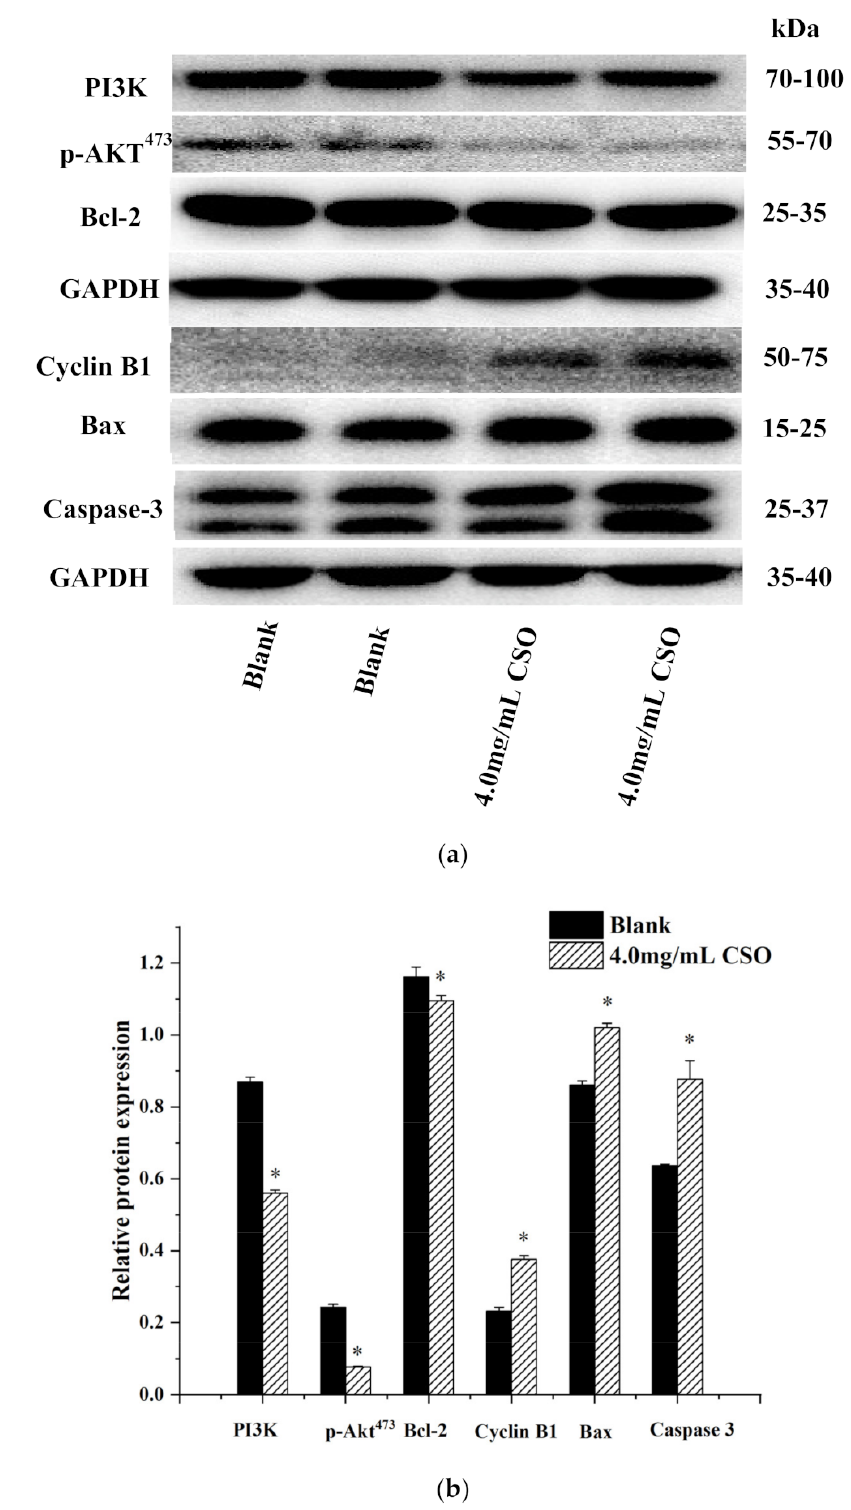
Figure 7. ( a ) Protein bands of PI3K, p-AKT 473 , Bcl-2, cyclin B1, Bax, and caspase-3, determined by Western blot; ( b ) protein expression of PI3K, AKT, Bcl-2, cyclin B1, Bax, and caspase 3 determined by Western blot; * p < 0.05, vs. the